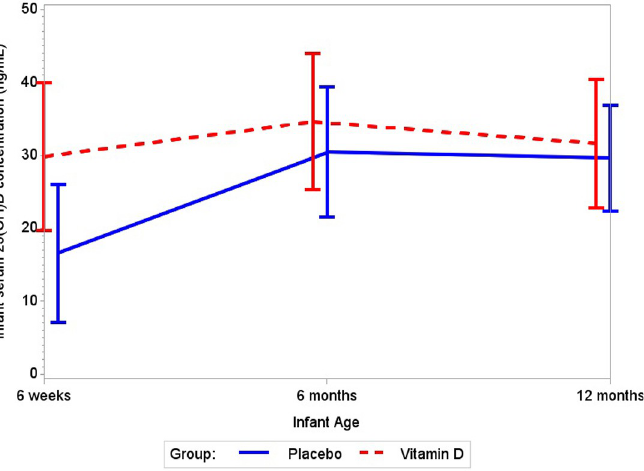
Fig 4. Effect of maternal vitamin D 3 supplementation on mean infant serum 25(OH)D concentrations. Whiskers indicate standard deviation. p- Value for difference in trajectory for infant serum 25(OH)D concentration < 0.001. 25 (OH)D, 25-hydroxyvitamin